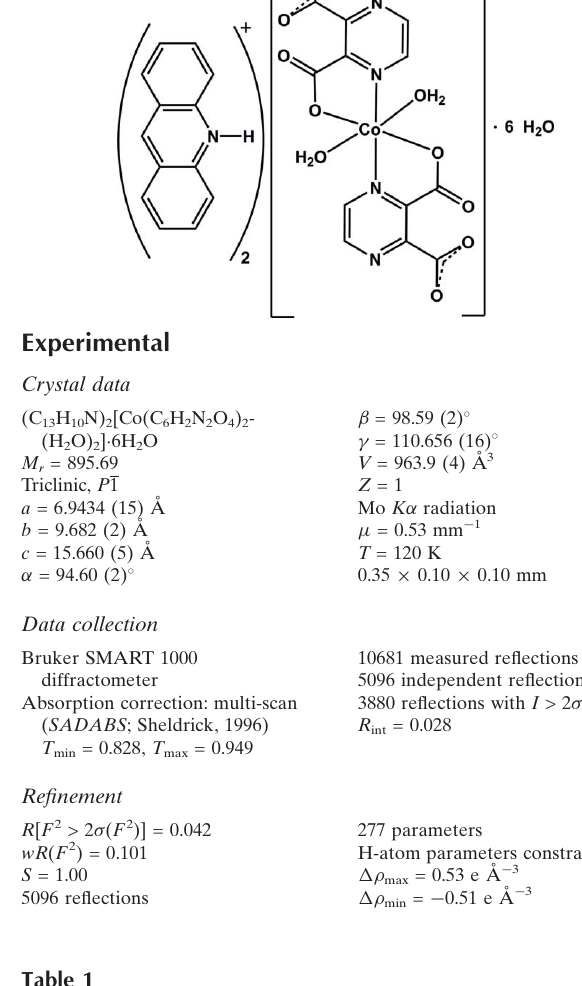
Hydrogen-bond geometry (A˚ , (cid:4)